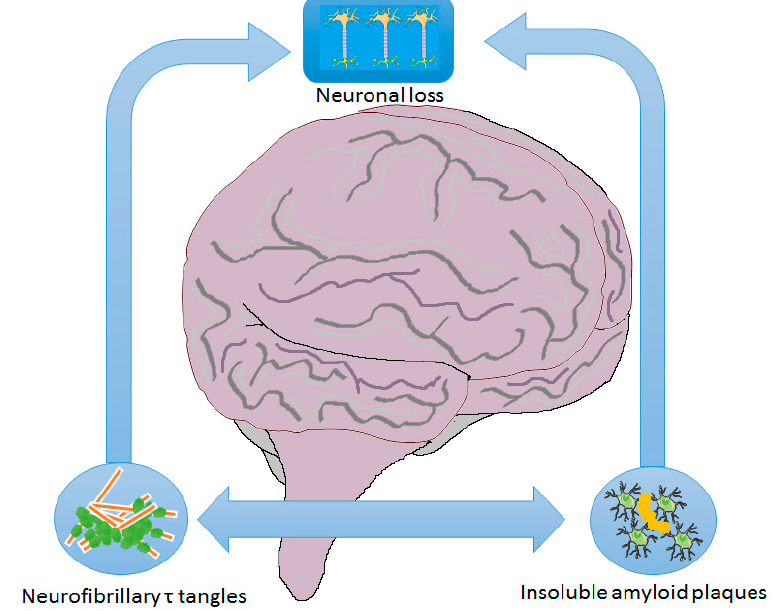
Figure 1. Major Alzheimer’s disease molecular signs.